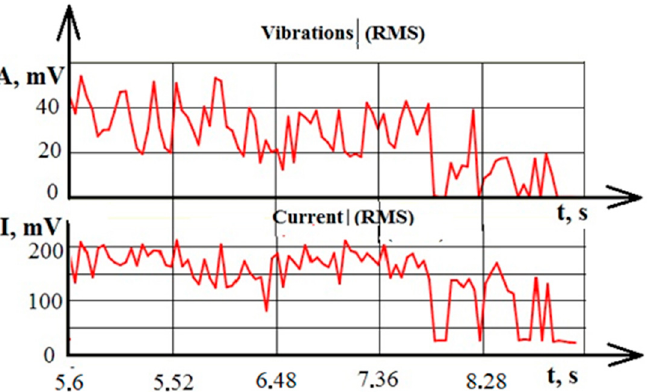
Figure 16. Changes in the RMS of the VA signal (range of 1–10 kHz) and the discharge current (pulse duration of 80%). duration of 80%).